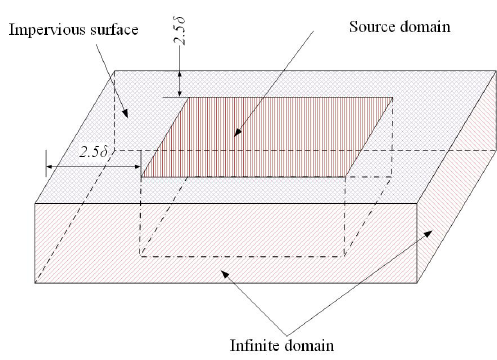
Figure 6. Schematic of sound simulation